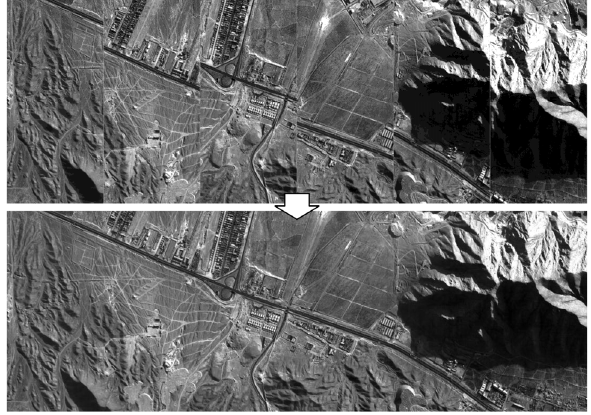
Figure 4. Multiscanned and structurally reconstructed